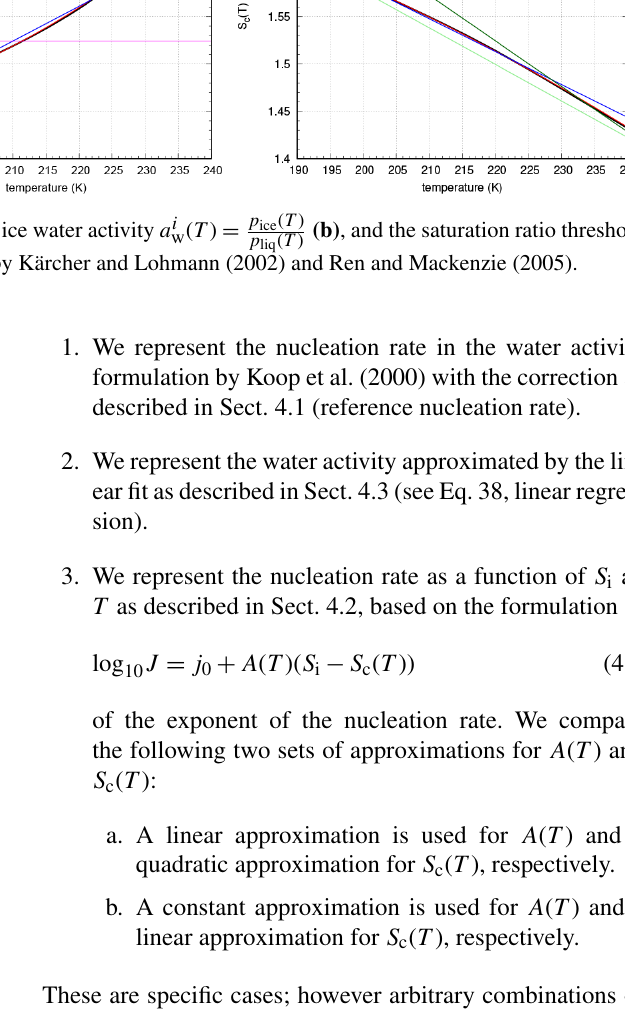
(b) , and the saturation ratio threshold p liq ( T )